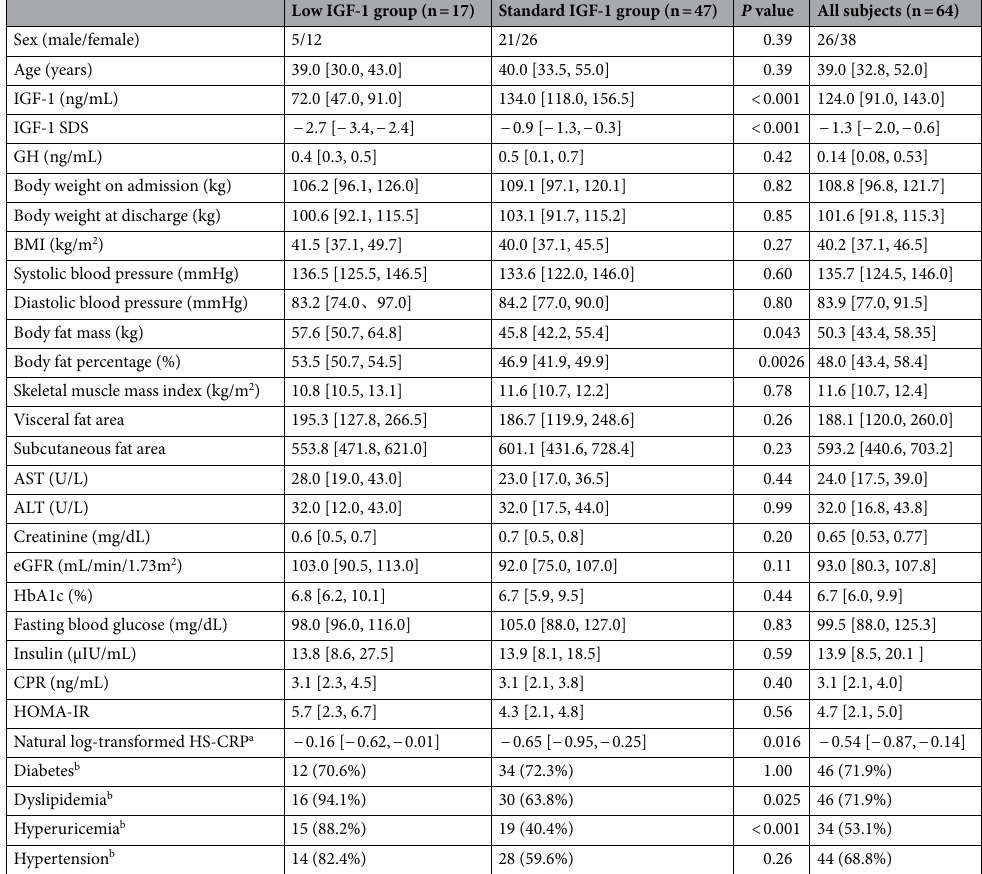
Table 1. Clinical parameters in low IGF-1 and standard IGF-1 groups. IGF-1 Insulin like growth factor-1, SDS standard deviation scores, GH growth hormone, BMI body mass index, AST aspartate aminotransferase, ALT alanine aminotransferase, eGFR estimated glomerular filtration rate, HbA1c hemoglobin A1c, CPR connecting- peptide immunoreactivity, HOMA -IR homeostatic model assessment for insulin resistance, HS-CRP high- sensitivity C-reactive protein. a Data was transformed as necessary to maintain assumptions of normality for the purposes of the analyses. b Values are the number